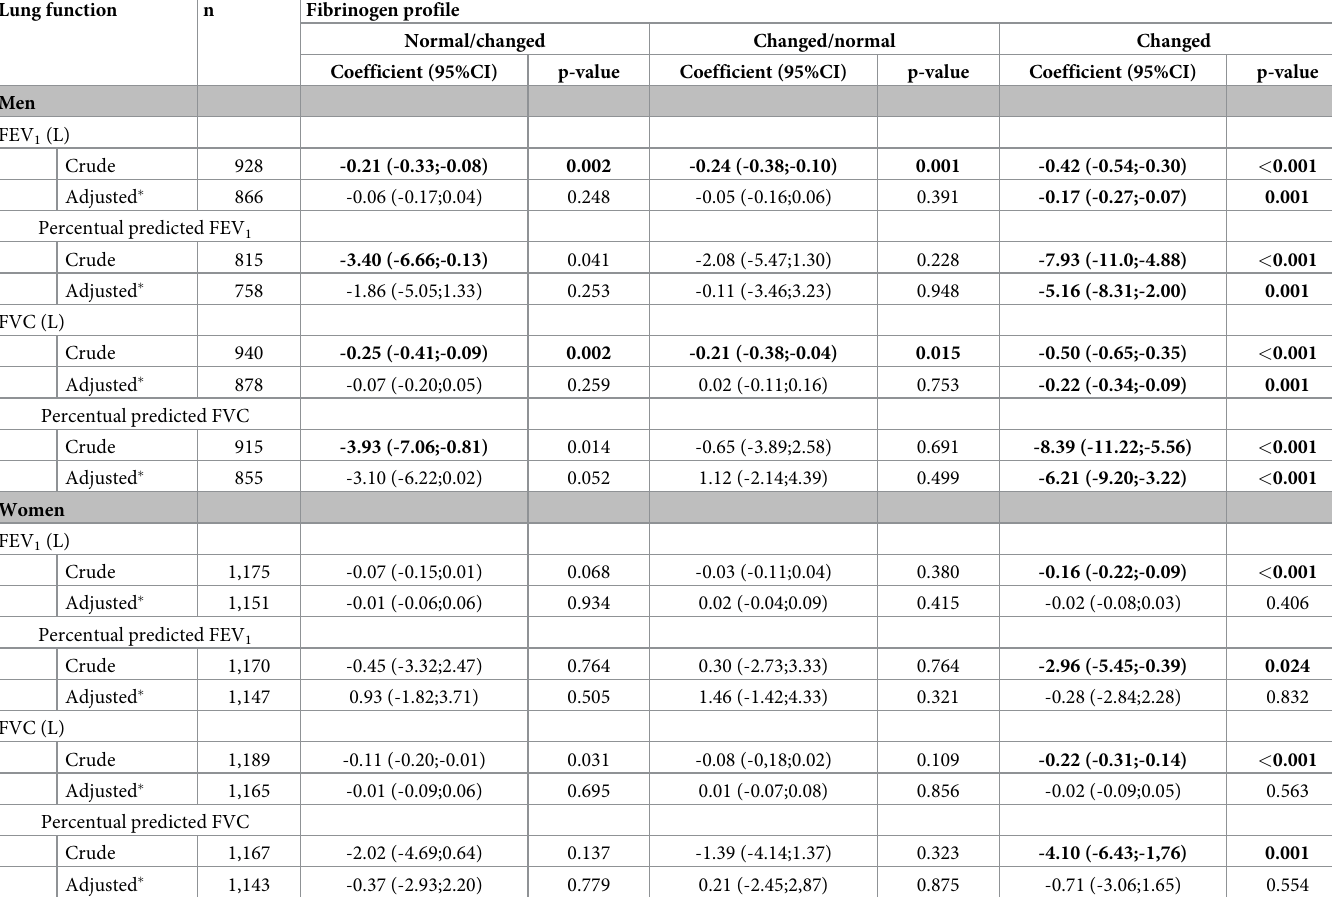
Table 2. Regression of FEV 1 (L), FVC (L), FEV 1 percentage of predicted and FVC percentage of predicted, by gender, The English Longitudinal Study of Ageing, England, 2004 to 2013. Lung